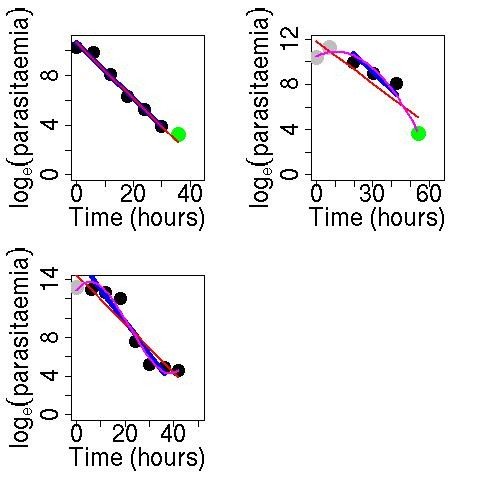
Linear and polynomial fits to the quadratic or cubic -shaped log(parasitaemia)-time profiles shown in Figure 3. Black points represent the data, green points represent censored values and grey points represent points identified as being part of the lag phase. Pink line shows cubic fit to the data, red line shows linear fit the data and blue line shows the linear fit to the identified 'linear part' of the profile.